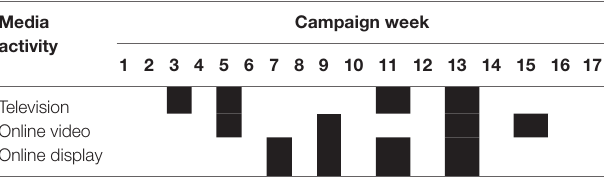
Television Online video Online display Black cells represent media